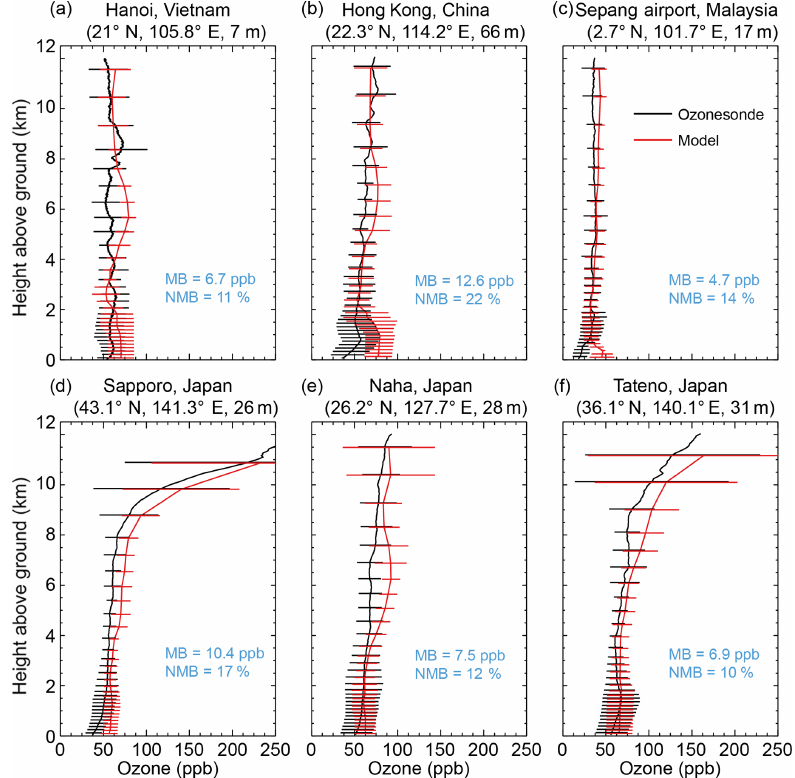
Figure 7. Model and WOUDC ozone profiles at six sites, averaged over multiple profiles. Horizontal lines indicate 1 standard deviation across multiple profiles. Mean bias (MB) and normalized mean bias (NMB) are shown in blue.